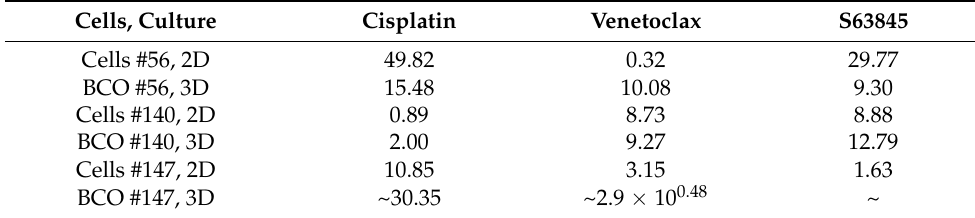
Table 2. Comparing drug effects in 2D versus 3D